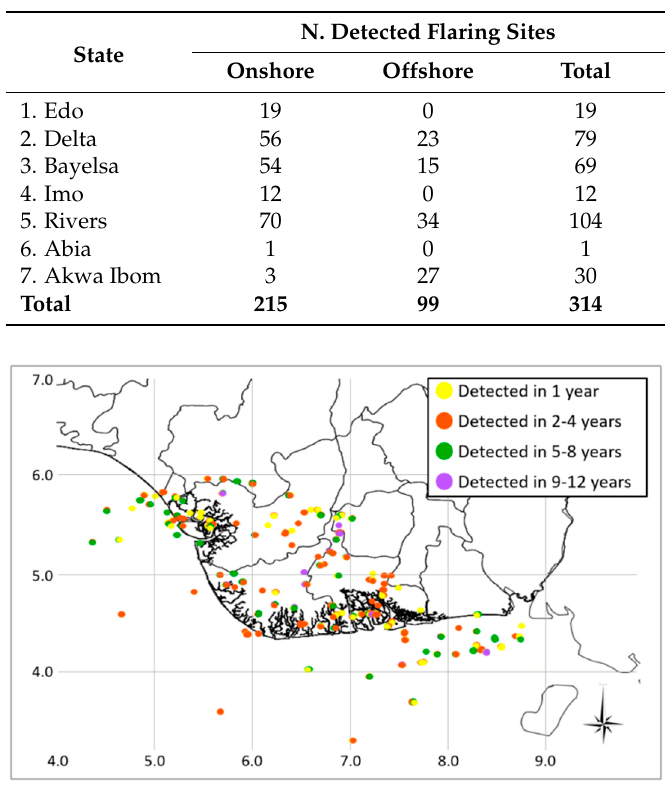
Figure 5. Temporal trend of total flaring sites detected applying RST-FLARE (black line) in the Niger Delta region, for each year from 2000 to 2016, as sum of onshore (green bars) and offshore (light blue bars) sites. Table 1. Distribution of flaring sites in the Niger Delta states between onshore and offshore.